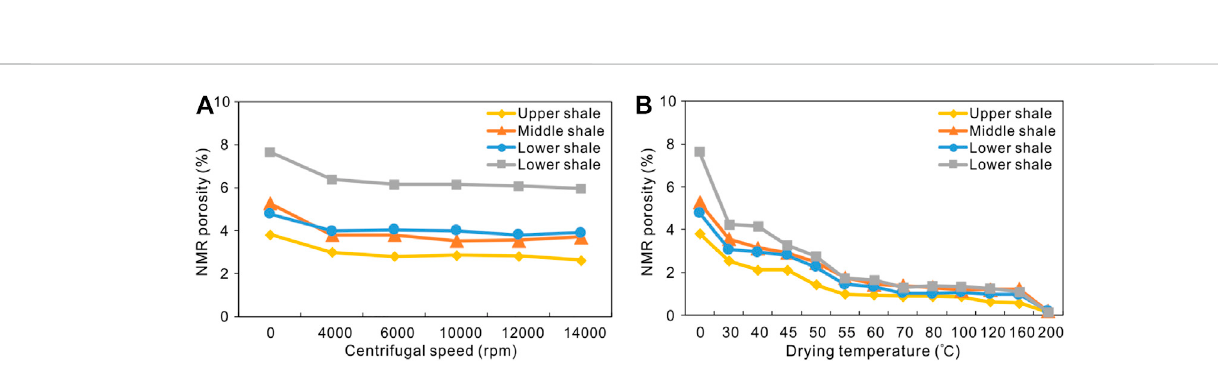
FIGURE 4 NMR porosity changes of Shan 2 3 Submember transitional shale under different centrifugation and drying